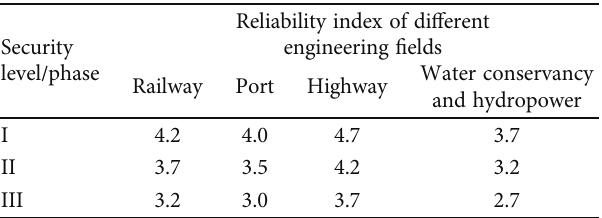
Table 12: Research results of target reliability in di ff erent engineering fi elds.